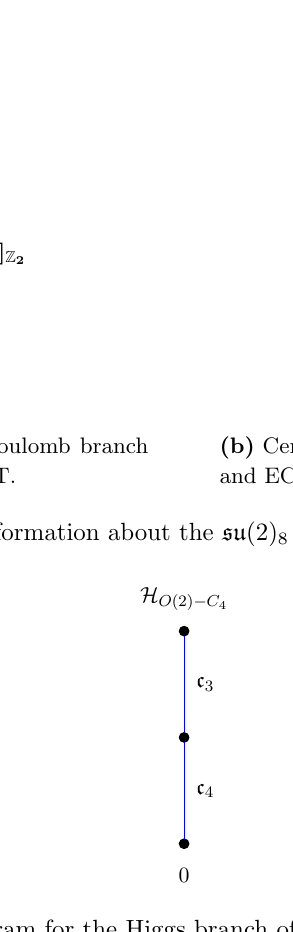
Figure 19. The Hasse diagram for the Higgs branch of the [ I (cid:3)